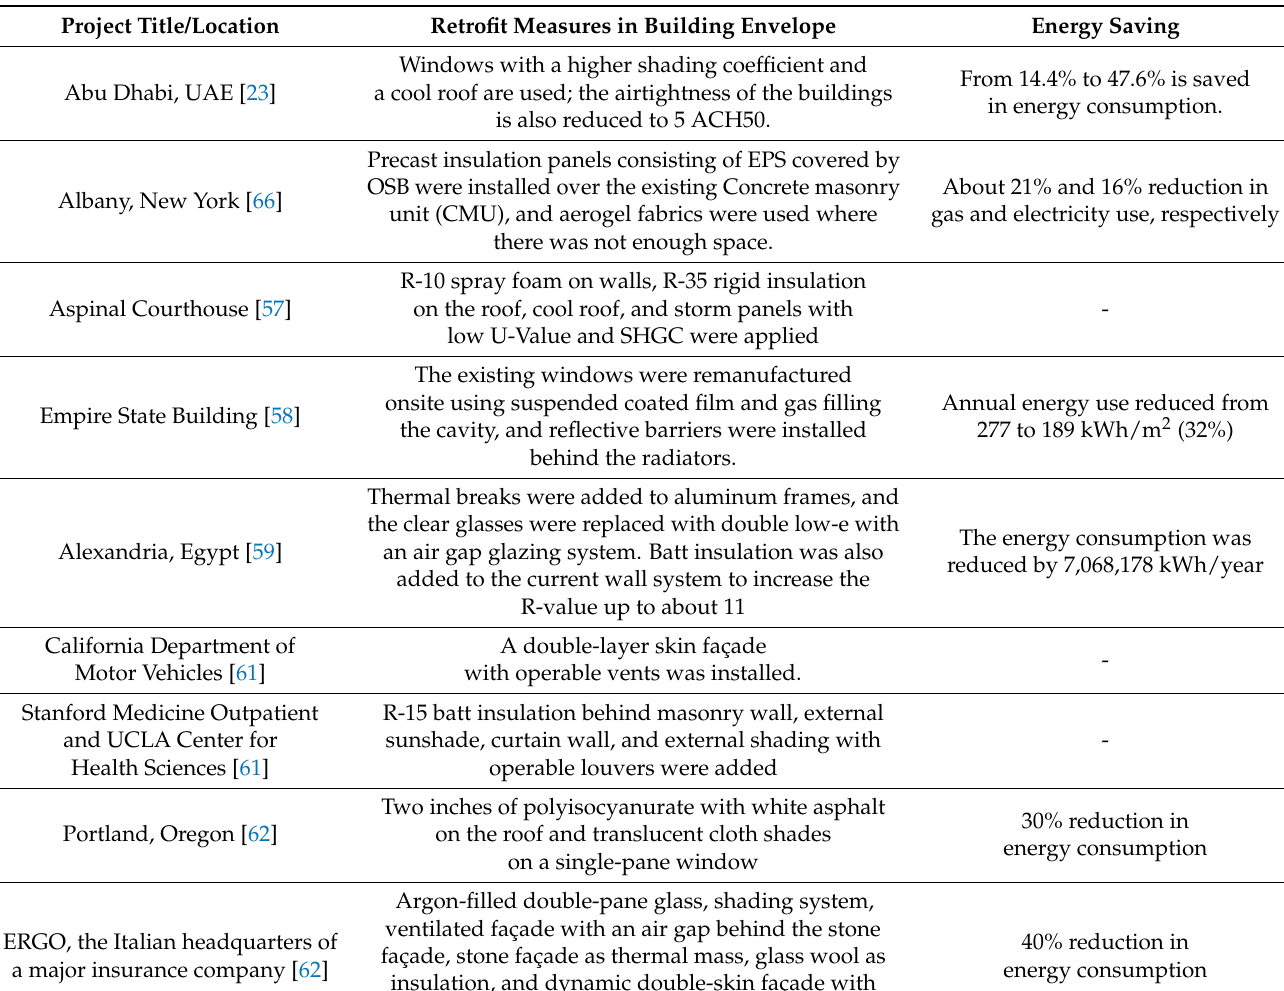
Table 6. Summary of the energy retrofit measures (ECMs) in example